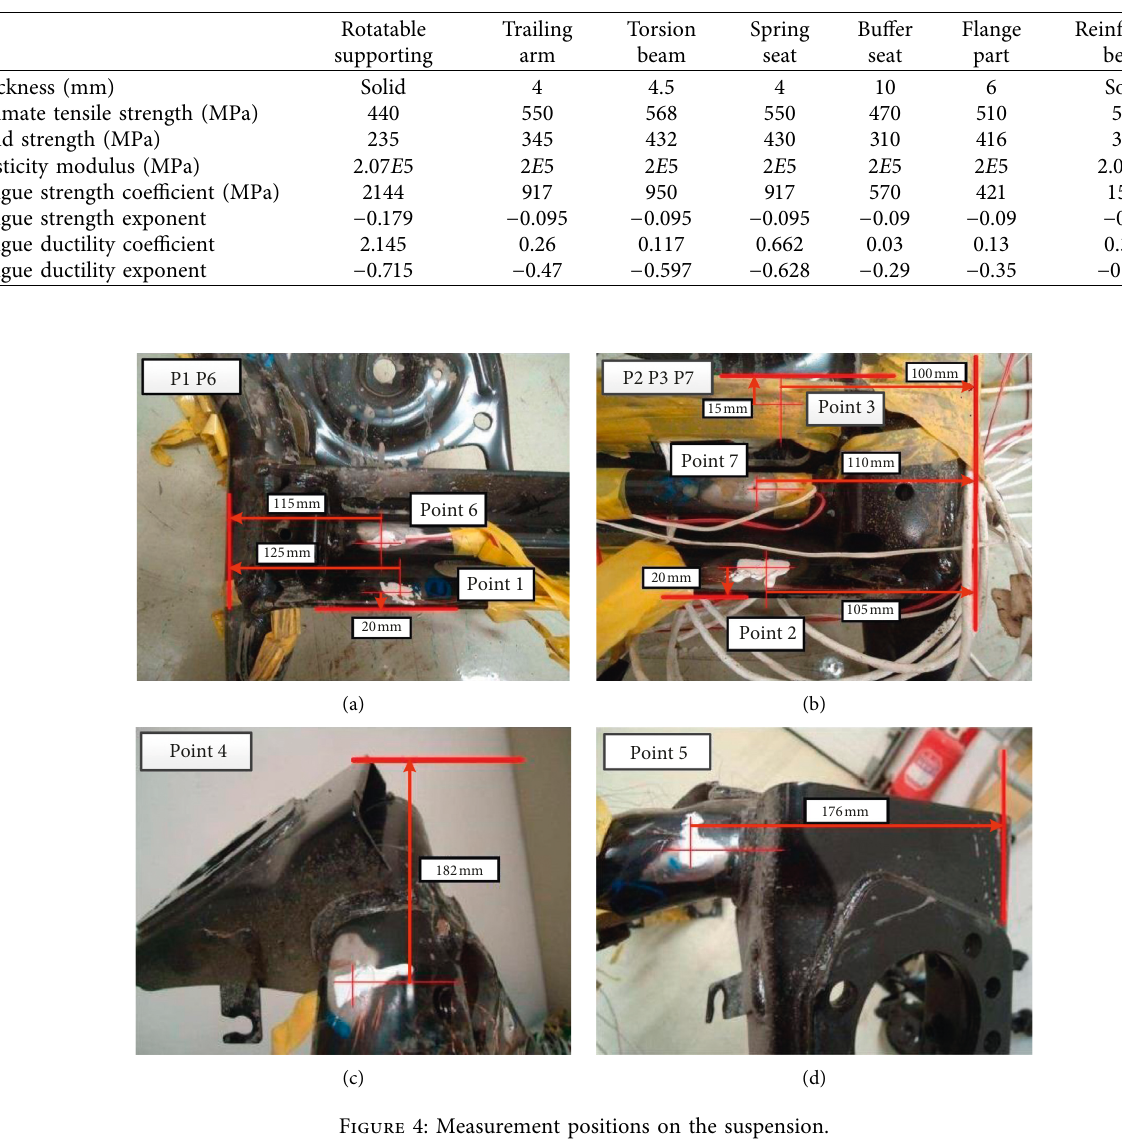
Figure 3: Target torsion beam rear suspension. Table 1: Material properties for each part of the torsion beam suspension.